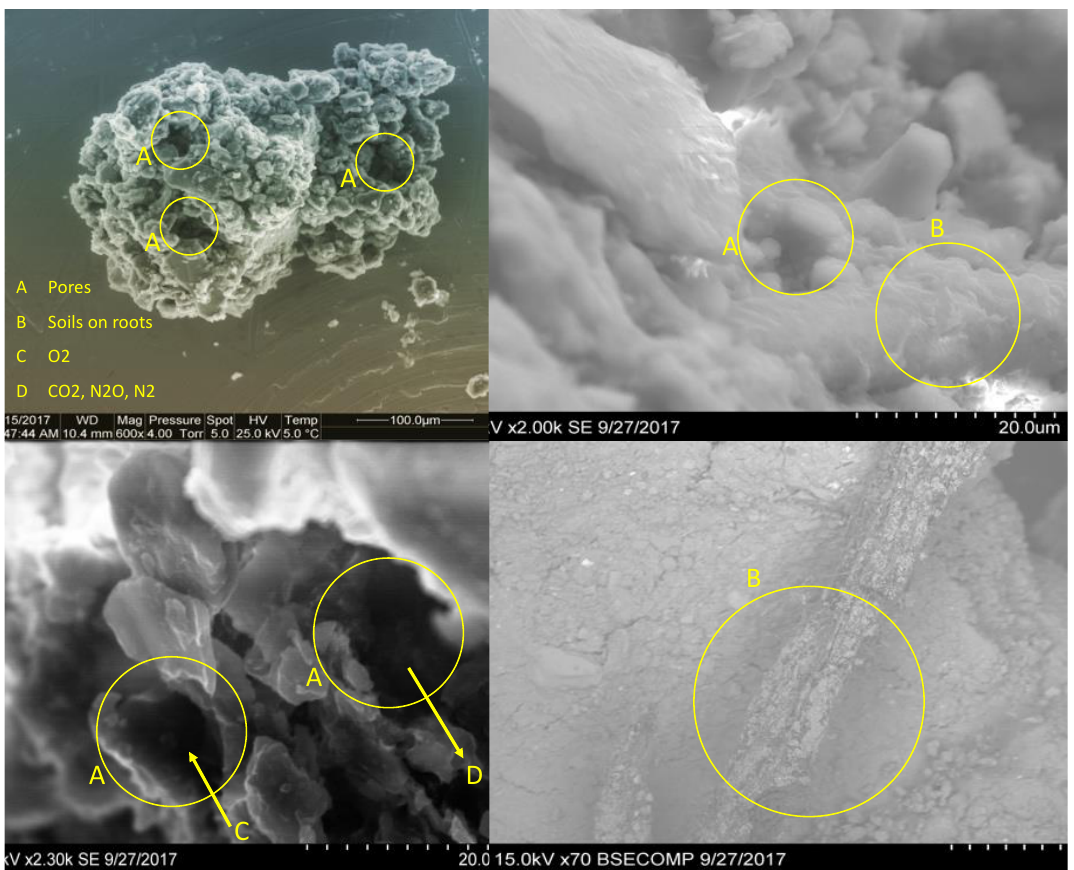
Figure 1. Soil aggregates and gas exchange within the soil pore system by SEM images.